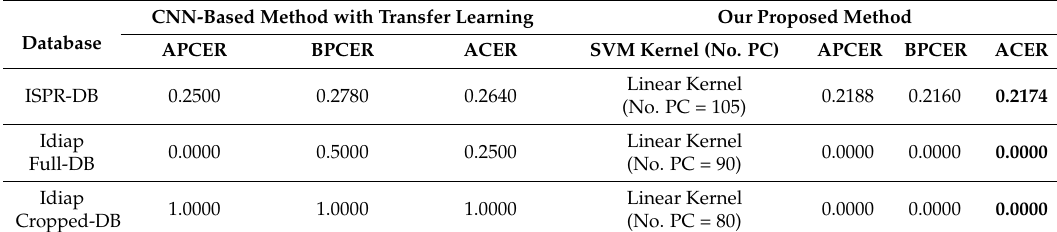
Table 19. Detection errors of CNN-based method and our proposed method using customized VGG-16 network in Table 5 (unit: